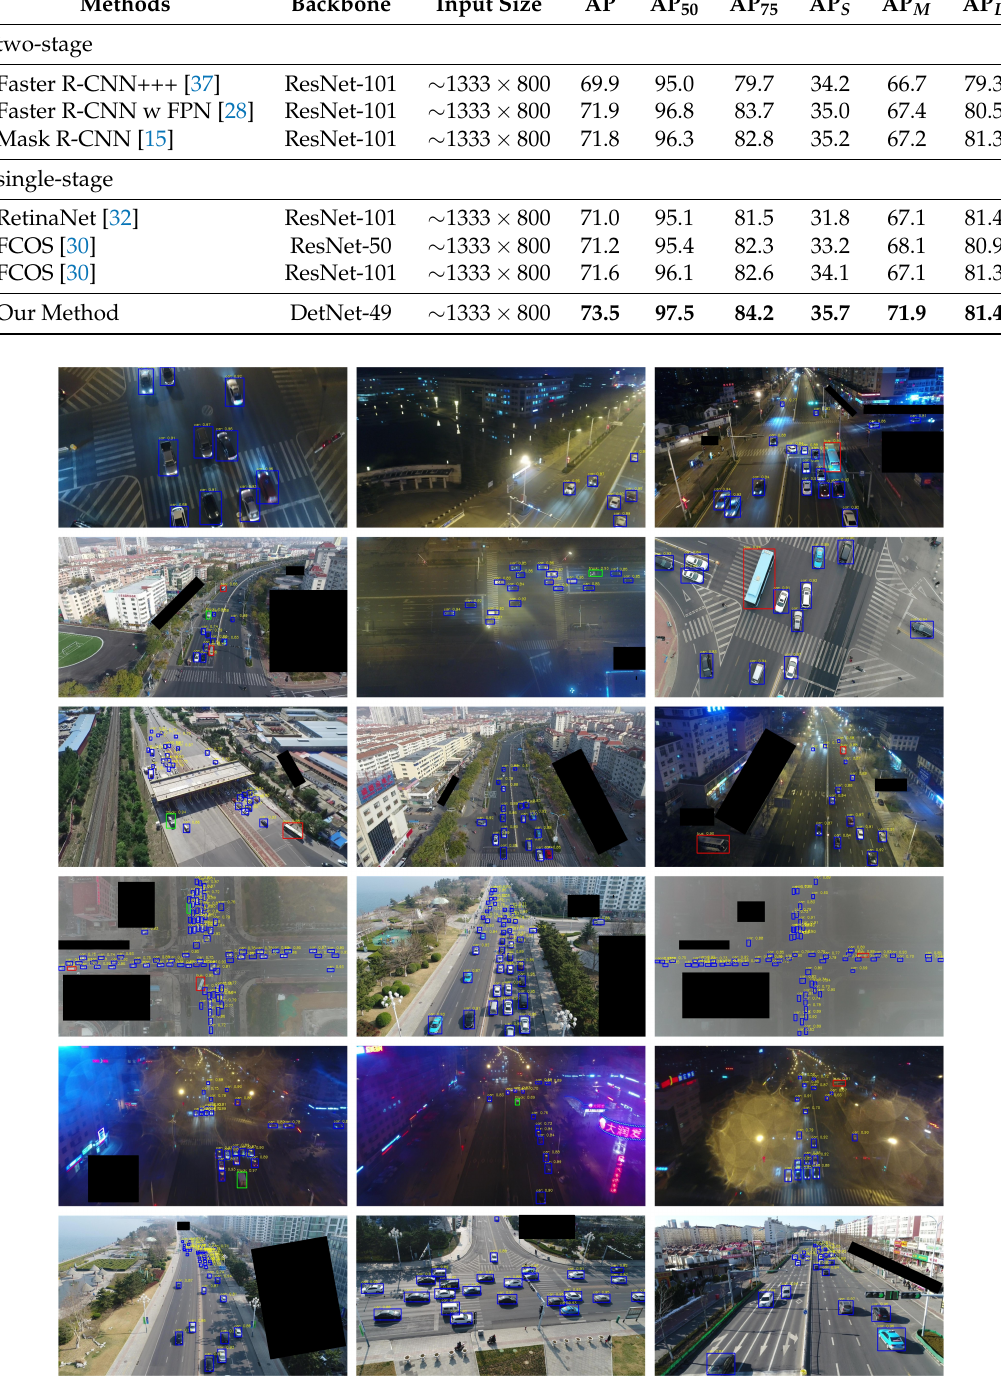
Figure 6. Qualitative detection results in different challenging scenarios. The black regions are ignored in the UAVDT